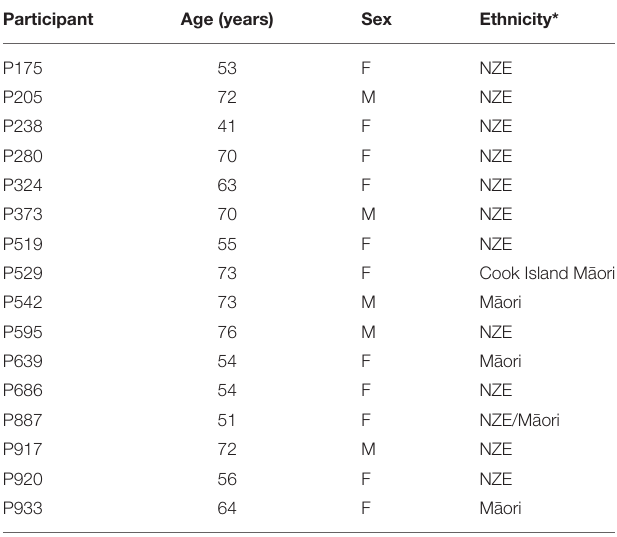
TABLE 1 | DCEP attendees age, sex and ethnicity